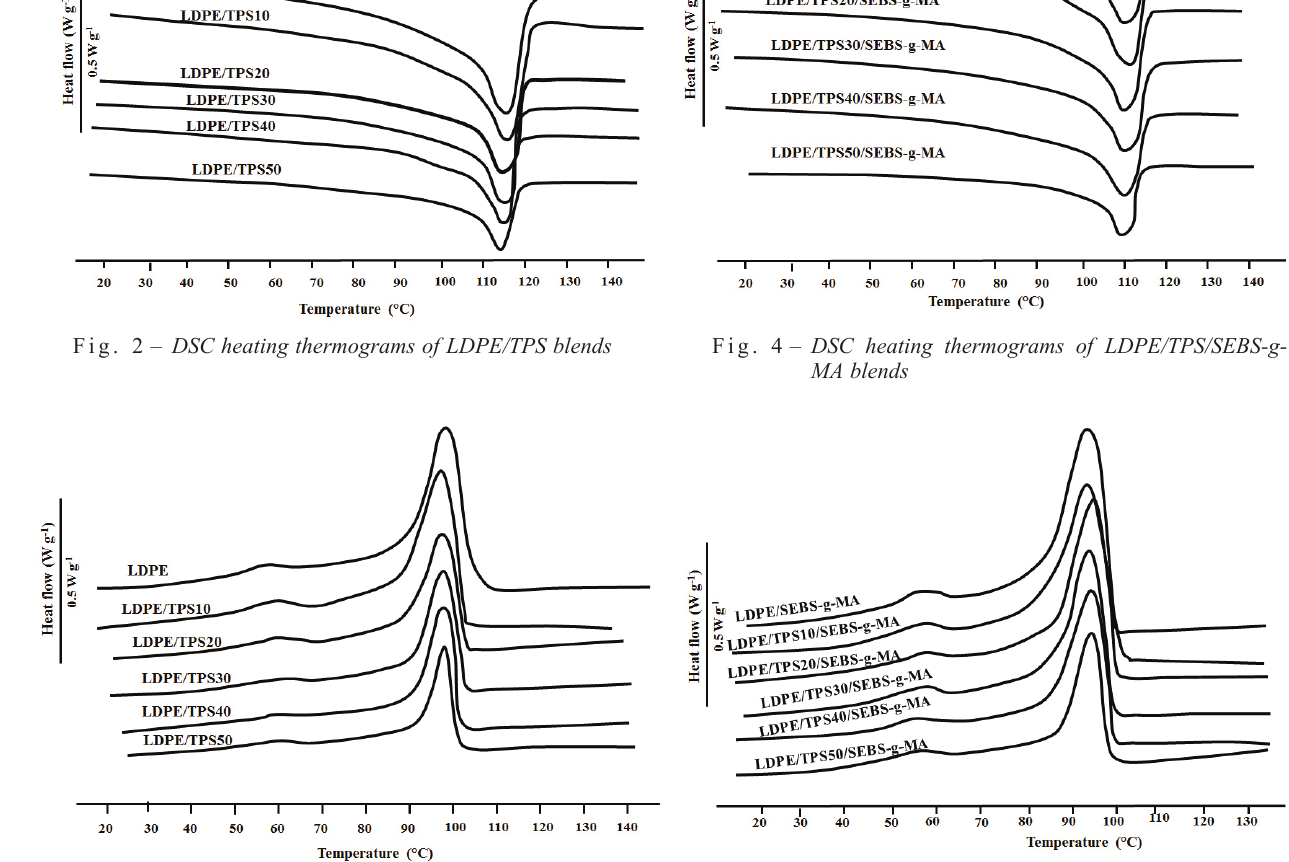
Fig. 3 – DSC cooling thermograms of LDPE/TPS blends Table 1 – Thermal properties of the investigated blends Sample